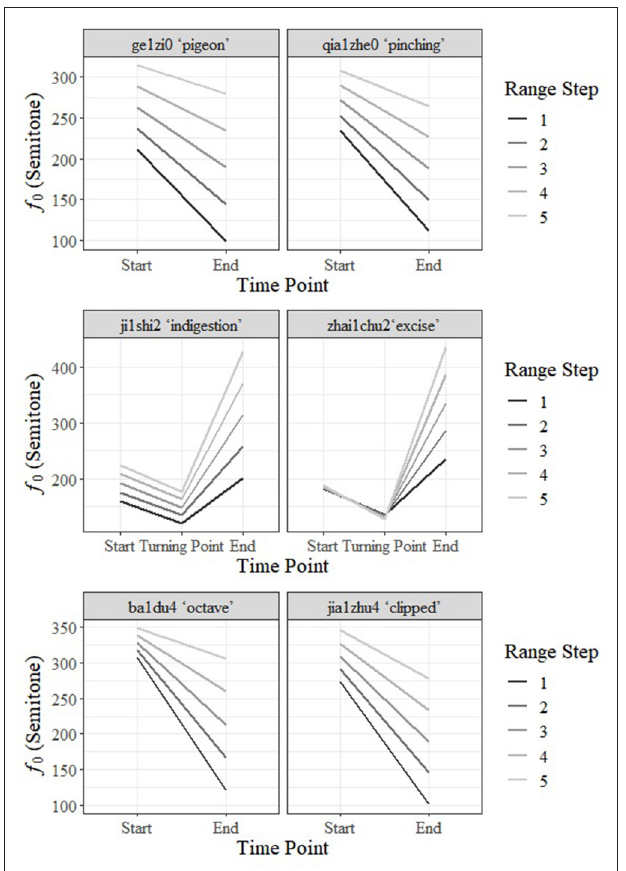
FIGURE 5 | Percentage of stimuli identified as questions ( question identified) by Range Step (A) and Height Step (B) .